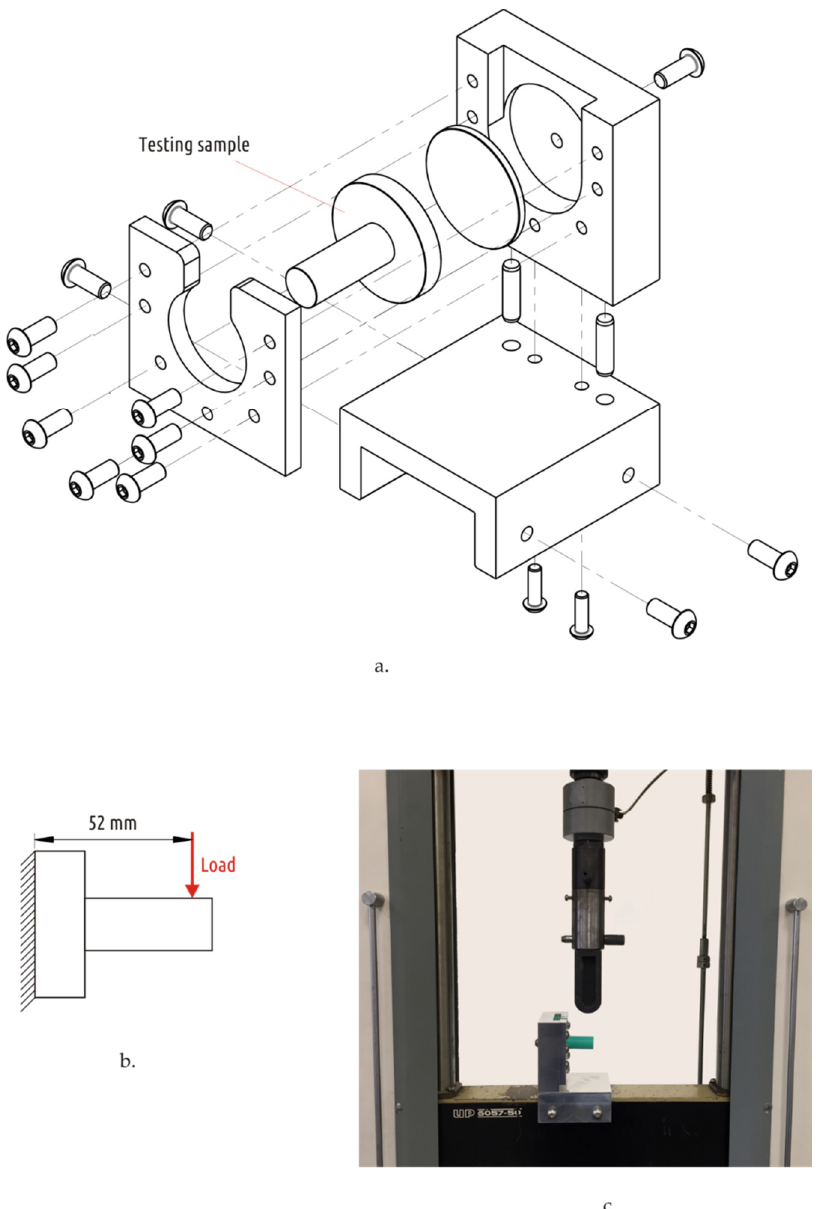
Figure 4. Sample fixture assembly ( a ), loading scheme ( b ), and overall view of testing apparatus ( c ).